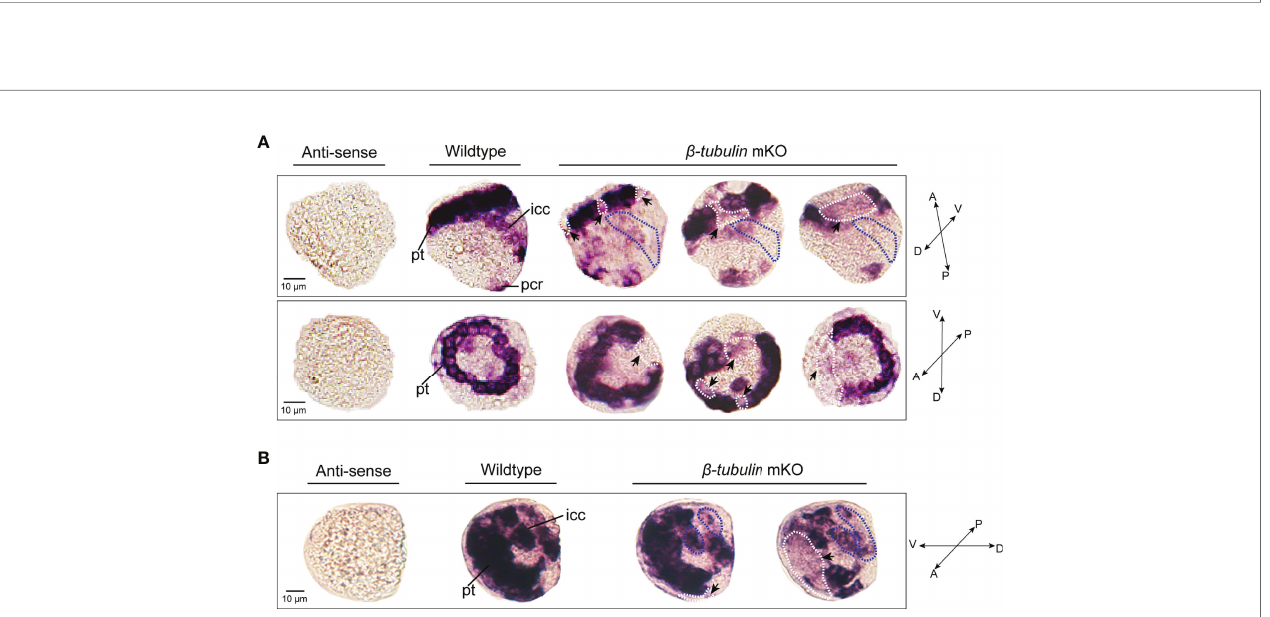
FIGURE 5 | Effects of b -tubulin somatic mutagenesis in C . gigas angulate larvae based on WMISH. The mosaic expression patterns of b -tubulin at the positions of peritroch (white dotted boxes) and intestinal cilia (blue dotted boxes) in C . gigas angulate trochophore (A) and D-shaped larvae (B) after Cg b -tubulin knock out. pt, peritroch; icc, intestinal cilia cluster; pcr, posterior cilium ring; A, anterior; P, posterior; D, dorsal; V,